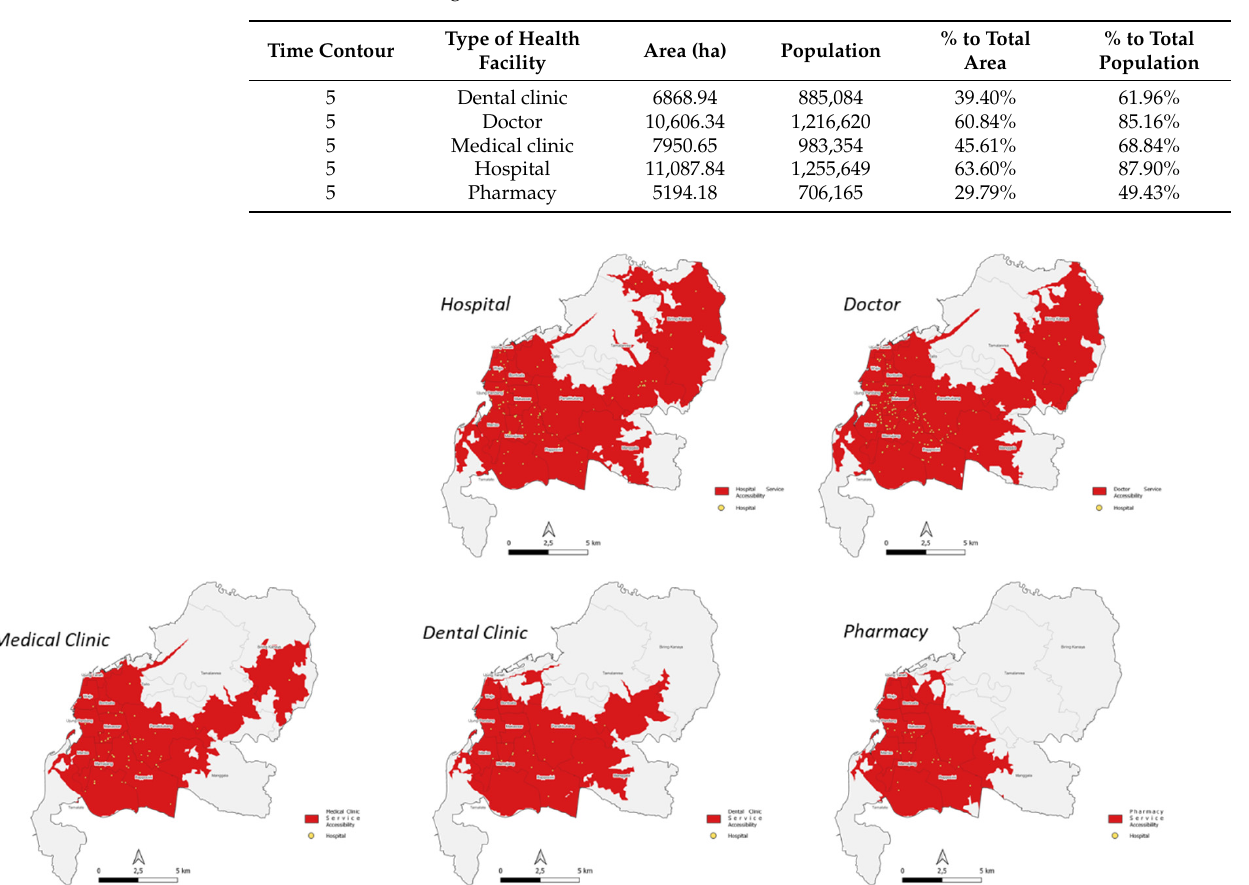
Table 5. Service Range of Health Facilities in 5-min Drive.